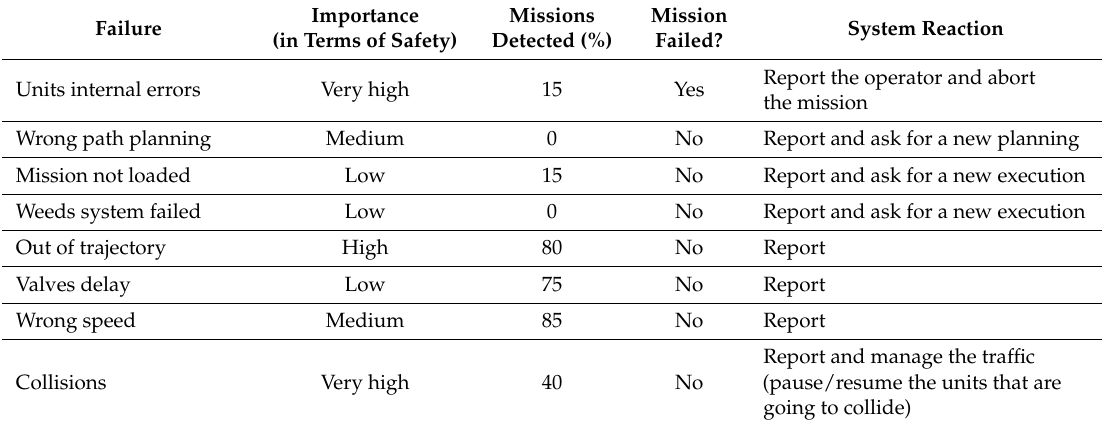
Table 3. Summary of trials